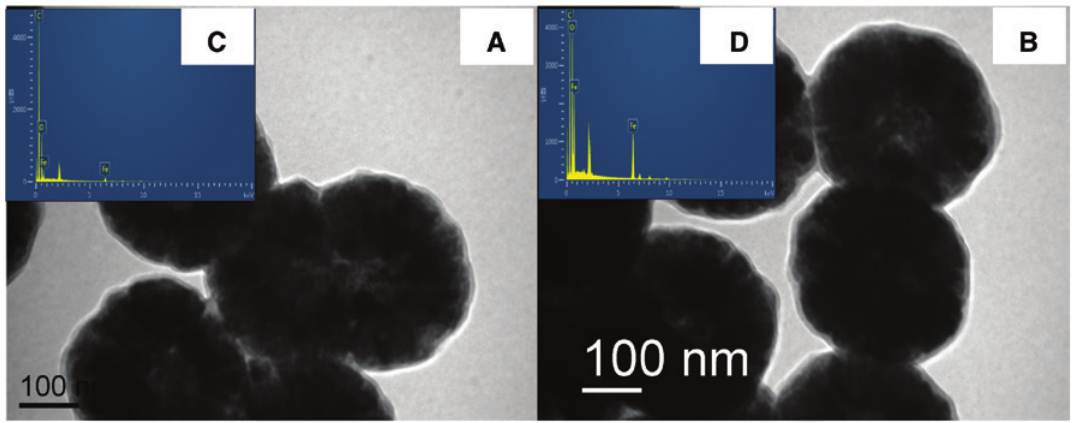
O /C (A, C) and Fe 3 4